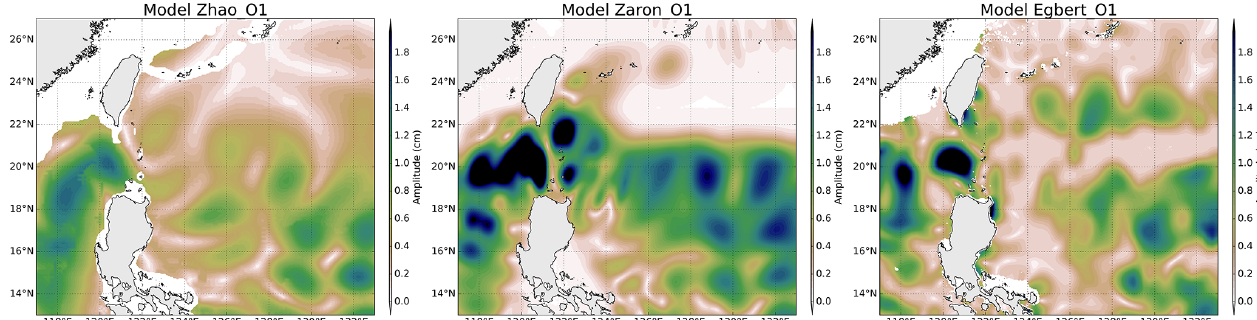
Figure A1. Amplitude of the IT models for the O 1 tide component in the Luzon area.